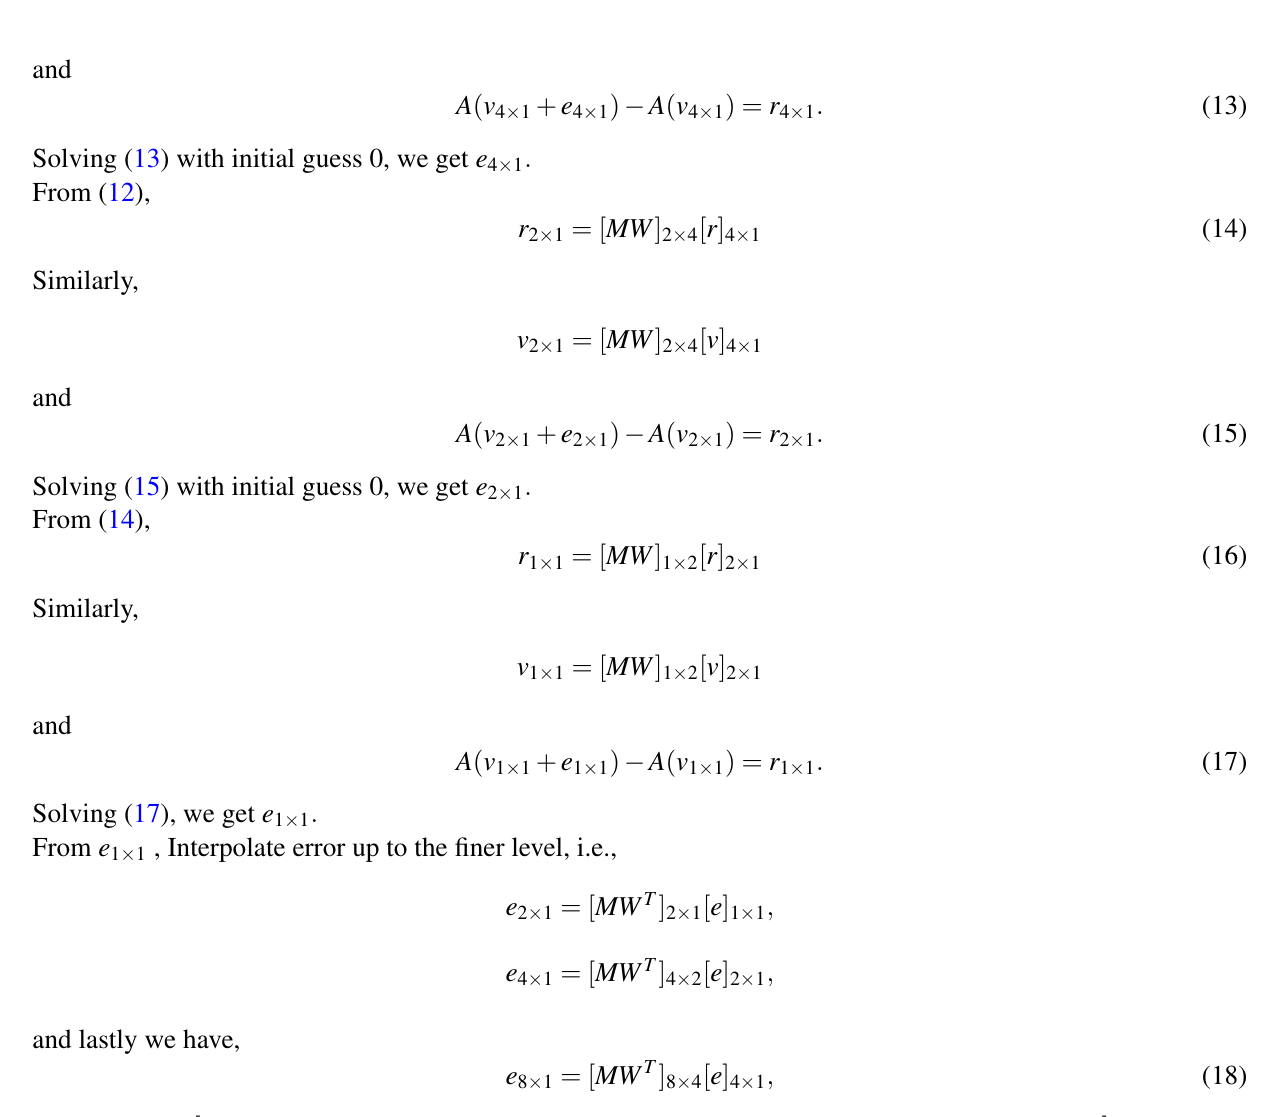
Table 1 Numerical results of test problem 5.1, for N = 8